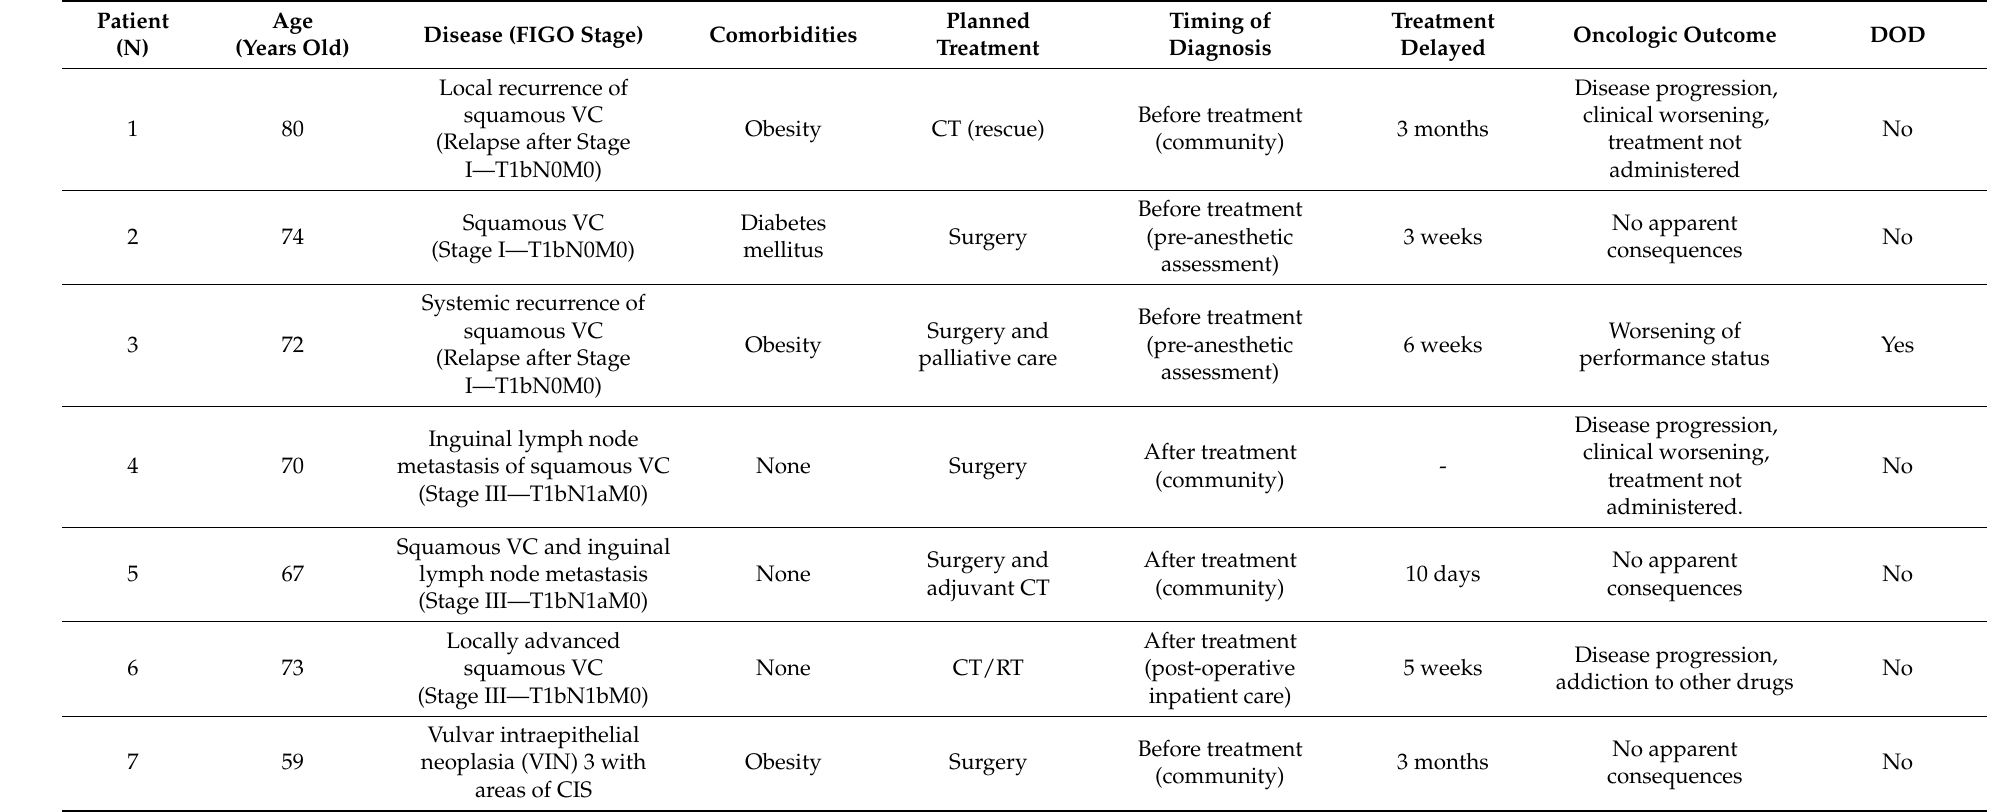
Table 1. Clinical characteristics of